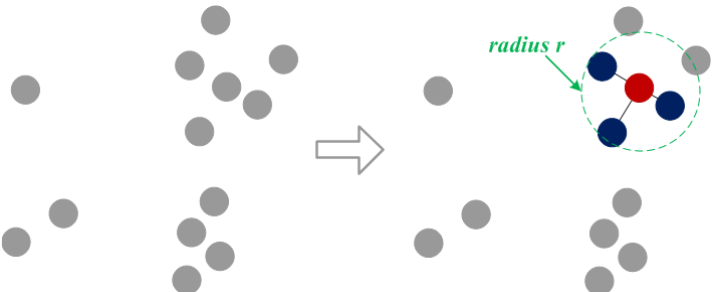
Figure 3. Construction strategy for edge features in the graph. Red indicates the vertex, and blue indicates its